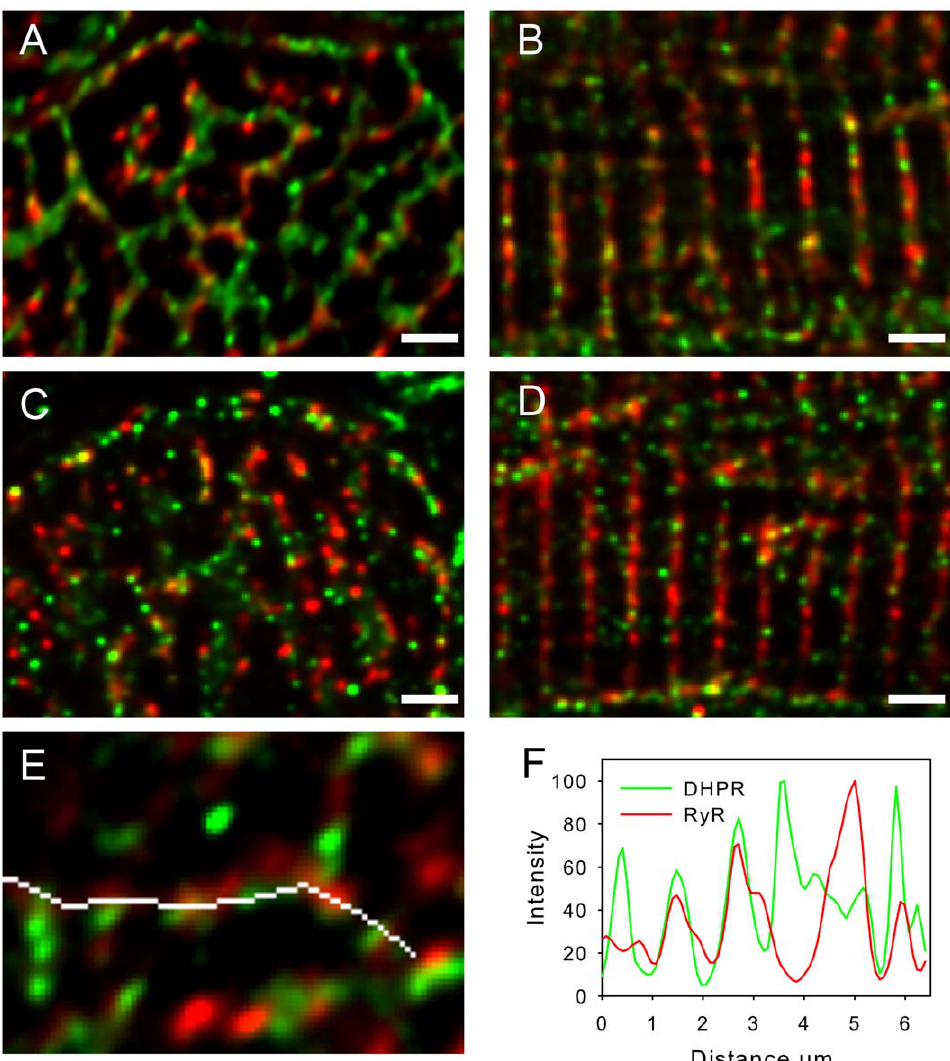
Figure 6. RyR and DHPR cluster colocalization is reduced in failing human cardiac myocytes. Panels A and B show images of control myocytes in transverse and longitudinal orientation respectively, labelled for RyR (red) and DHPR (green). Panels C and D show images of diseased myocytes in transverse and longitudinal orientation respectively, labelled for RyR (red) and DHPR (green). Images are z projections of 4 optical sections with z depth of 1 m m. Scale bars are 2 m m. Panel E shows an exemplar region of DHPR and RyR labelling in a normal cell, this image is a single optical section. The white line indicates the position of intensity readings along a WGA labelled t-tubule (label not shown for clarity). Panel F shows the intensity profile of DHPR and RyR labelling along the white line shown in panel E . Similar results were seen with an alternative DHPR antibody (see methods and supplementary Figure S1).